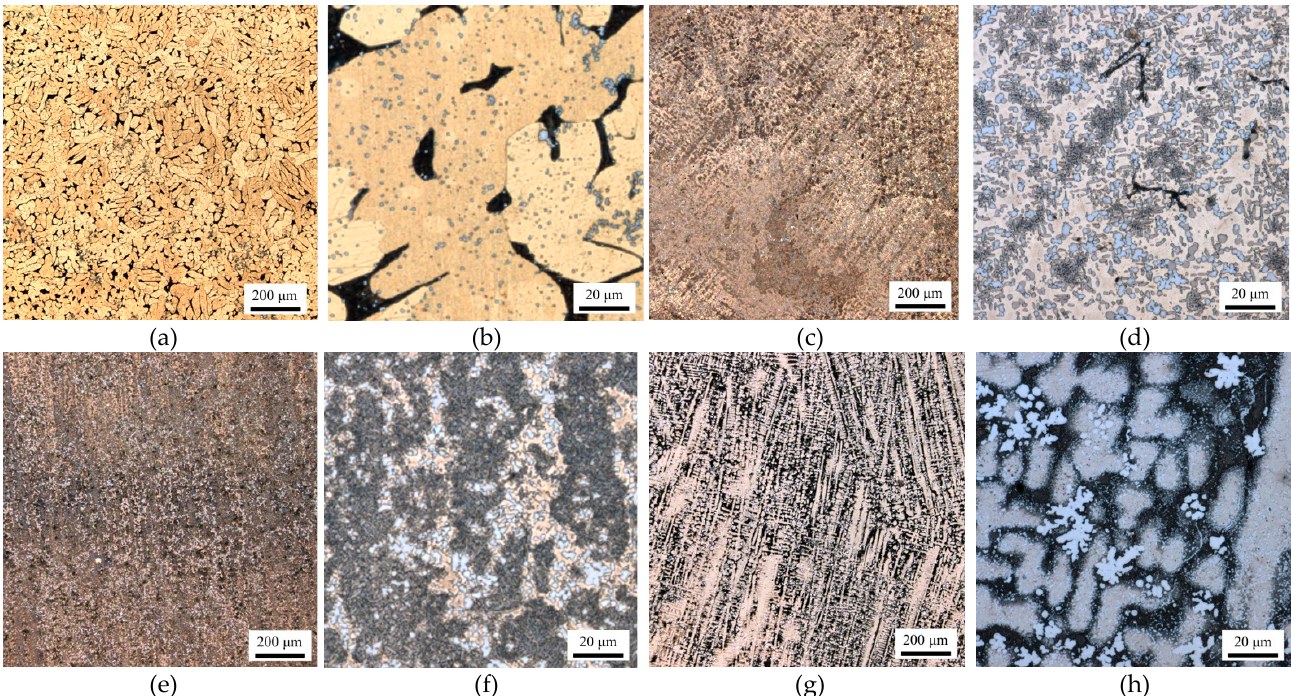
Figure 3. Optical metallography images of bronze/Inconel multimaterial samples produced with 5%Ni ( a , b ), 15%Ni ( c , d ), 25%Ni ( e , f ), and 50%Ni ( g , h ) with different magnifications.